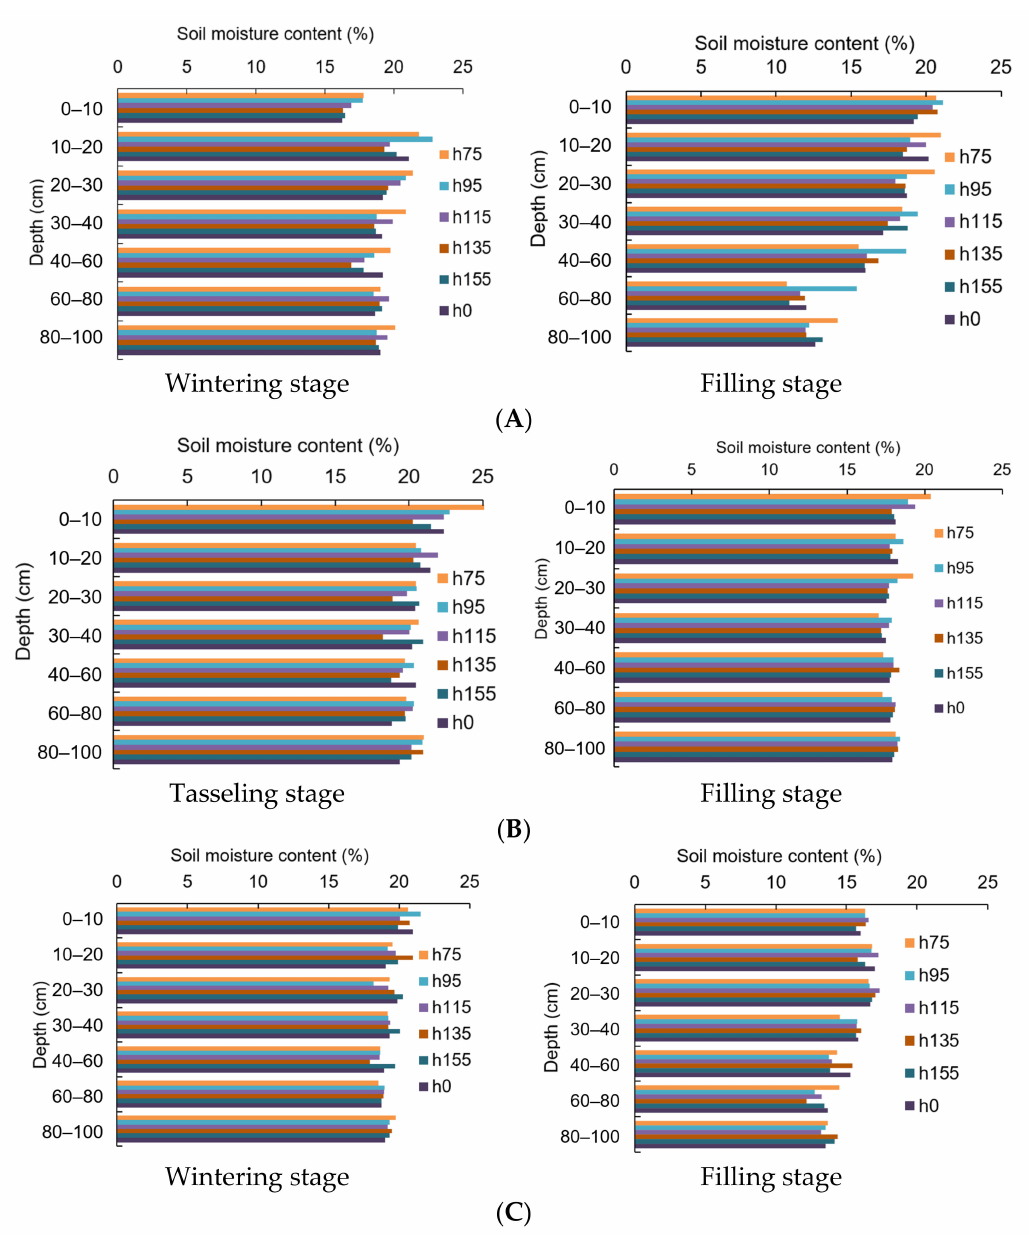
Figure 5. Soil moisture content for winter wheat in the first growing season (WW1) ( A ), summer maize (SM) ( B ), and winter wheat in the second growing season (WW2) ( C